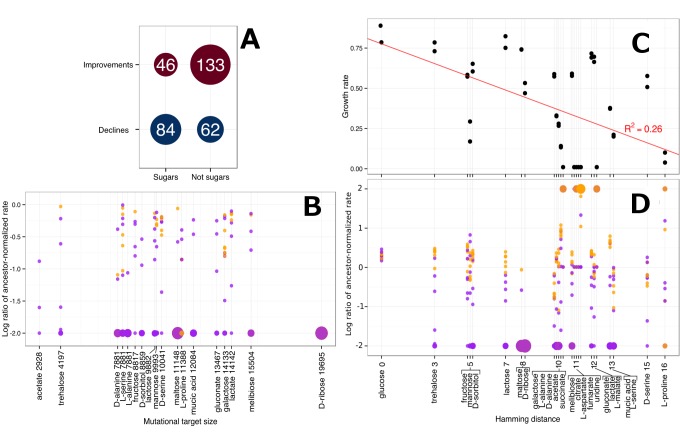
Substrate dissimilarity does not predict metabolic erosion.(A) A simple categorization of substrates as sugars and nonsugars finds that the correlation between relatedness to glucose and evolved metabolic changes is the opposite from what is hypothesized. (B) The FBA-predicted mutational target size does not correlate with decreases in growth rate. (C) Hamming distance between FBA-generated flux vectors for carbon sources partially predicts ancestral growth rate. Black dots indicate the growth rate of the two ancestral strains. A total of 268 reactions were predicted as necessary for optimal metabolism on glucose. (D) Hamming distance between a substrate and glucose does not correlate with increases or decreases in growth rate. The y axis is the log of the ratio of growth rate relative to the ancestor, with all ratios greater or less than e
2 binned at the axis limit. For (C–D), purple dots are mutator strains, and orange dots are nonmutators. Larger dots at the axis extrema indicate more overlapping points, and the shading between purple and orange indicates the different proportions of mutators and nonmutators at that limit. For (B–D), substrates with the same x axis values were plotted with a slight offset, and the true value is listed in the axis label.